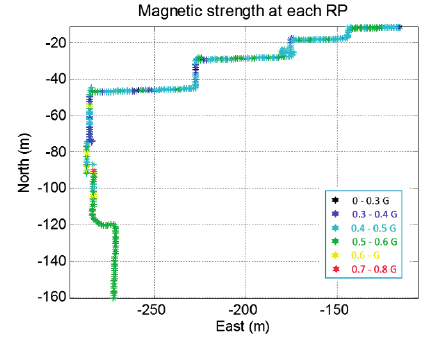
Figure 15. Magnetic distribution at